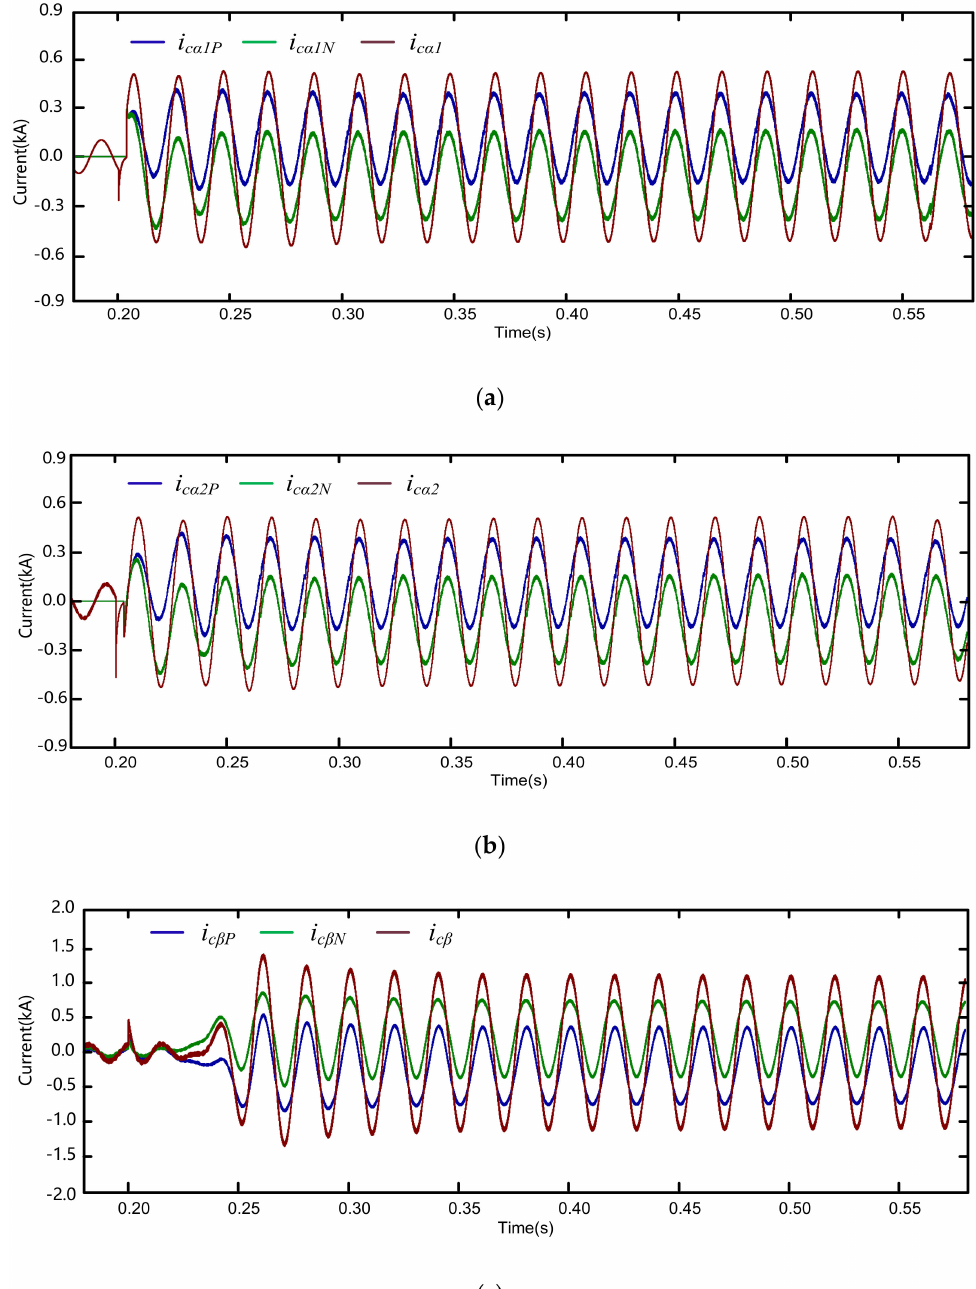
Figure 6. Upper leg current, lower leg current and output current in UPSP mode: ( a ) upper leg current; ( b ) lower leg current; ( c ) output